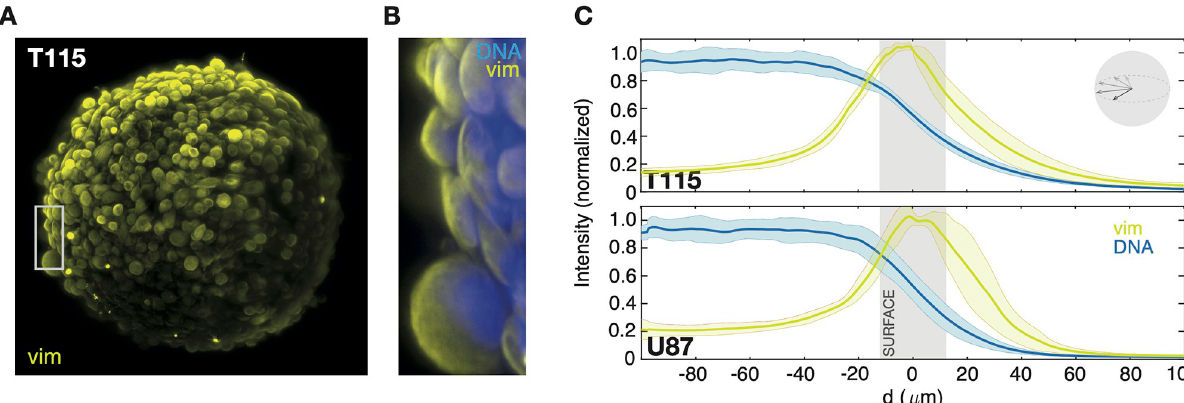
Fig 3. Spatial patterns of markers in 3D. A: Natural spheroid formation primary brain cancer (T115) in liquid cell culture. Maximum intensity z- projection of immunofluorescent vim (yellow). B: Merged image of the region of interest in (B) with immunofluorescent vim (yellow) and nuclei stain (blue). C: Radial distribution of vim (yellow) and nuclei stain (DNA, blue) versus the distance from the spheroid’s surface, d , for both cell lines. The full line is the mean immunostain intensities averaged over different spheroids (N = 4), the shaded areas designate one standard deviation, and the grey vertical bar (SURFACE) indicates the roughness of the spheroid’s surface; corresponding to 1–2 cell widths. Inset: Sketch of how the intensity distribution over the radial vector is averaged. Intensities are measured for a rotating radial vector in a 4 μ m slice (10 images) of the spheroid (50 μ m depth) as detailed in Materials and